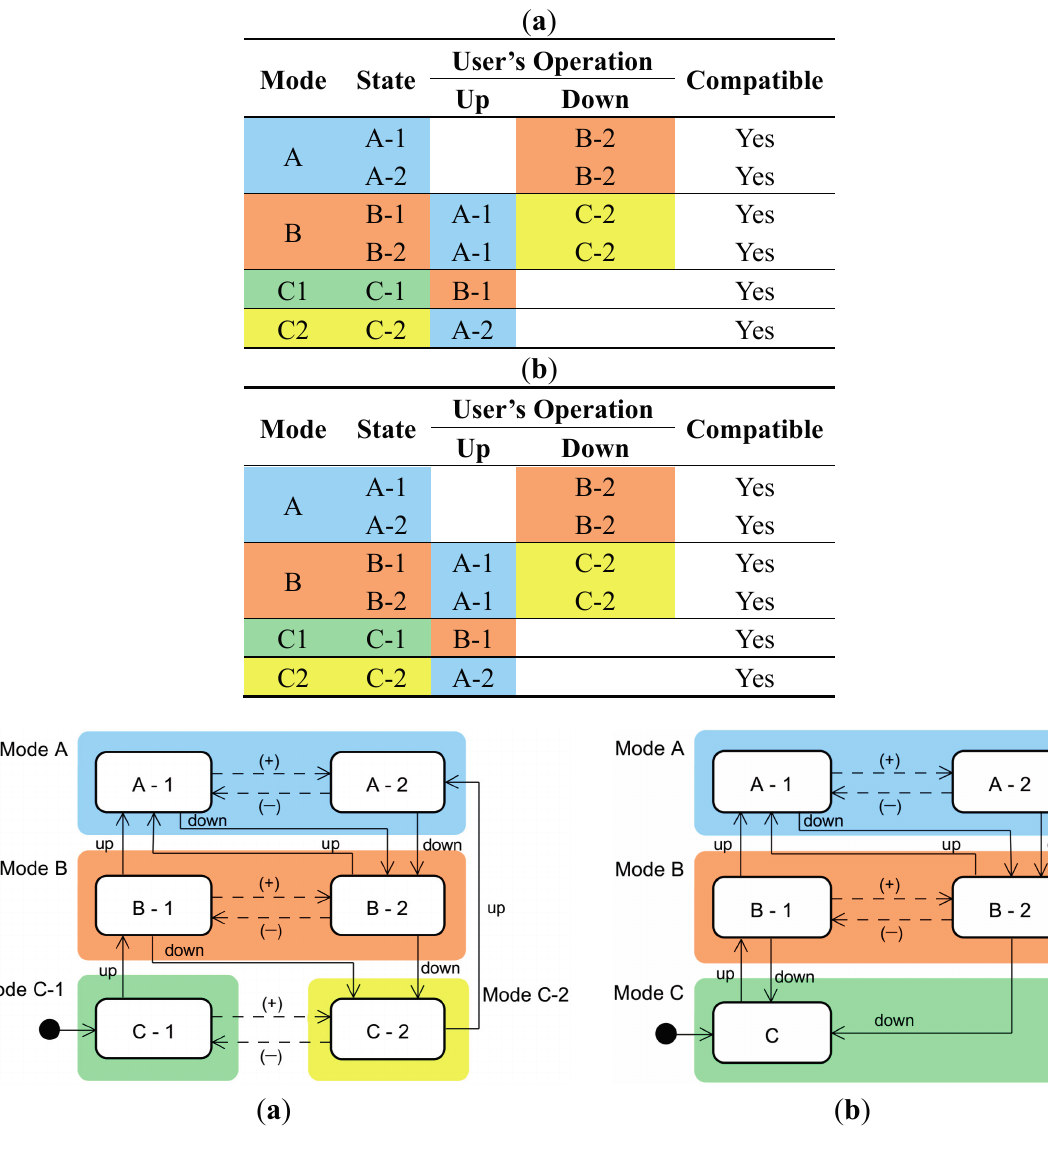
Table 2. State and mode transitions of the modified interface model for the example machine: ( a ) modifying the interface model; and ( b ) modifying the machine model.